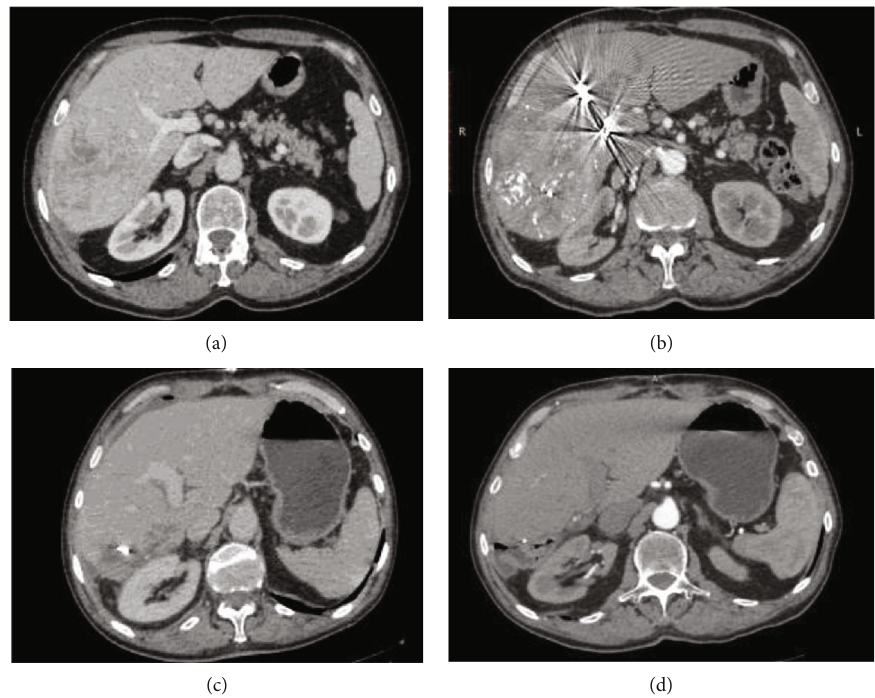
Figure 6: (a) CT scan before TACE and PVE. (b) One month after PVE and three months after TACE, anticipated hypertrophy of LLL is observed. On CT scan, one month (c) and three months (d) after liver resection, there is no evidence of HCC recurrence. Signi fi cant hypertrophy of the liver remnant is